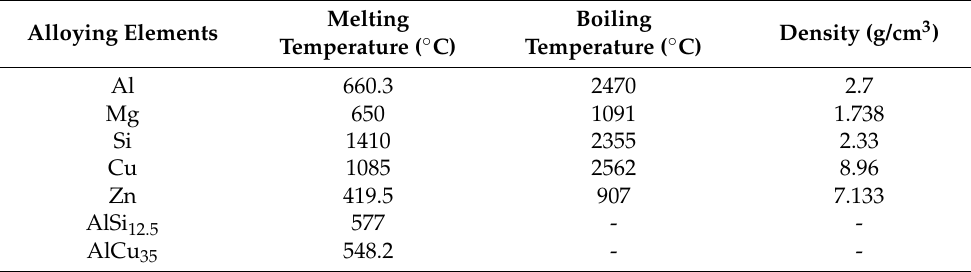
Table 1. Physical information about the utilized alloying elements and master alloys.